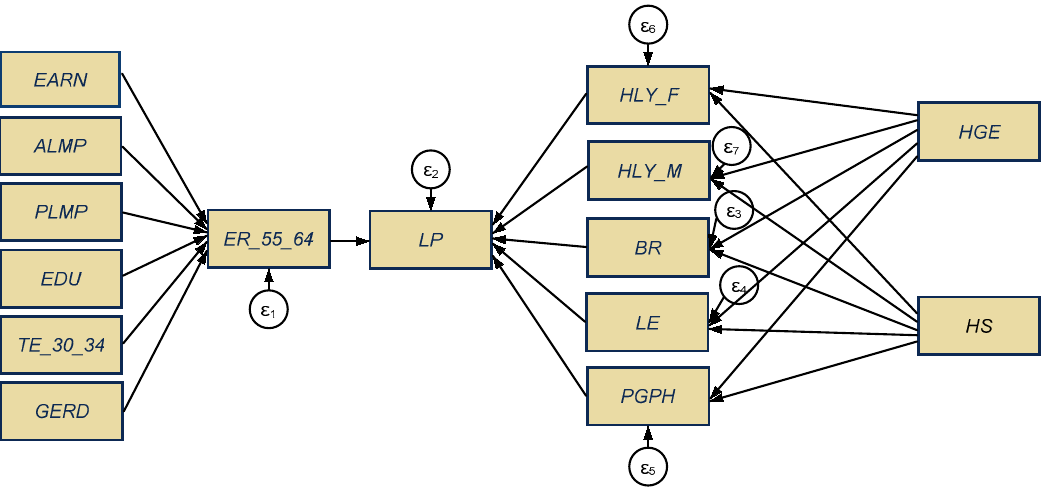
Figure 4. General configuration of structural equation modeling (SEM). Source: Own contribution in Stata.